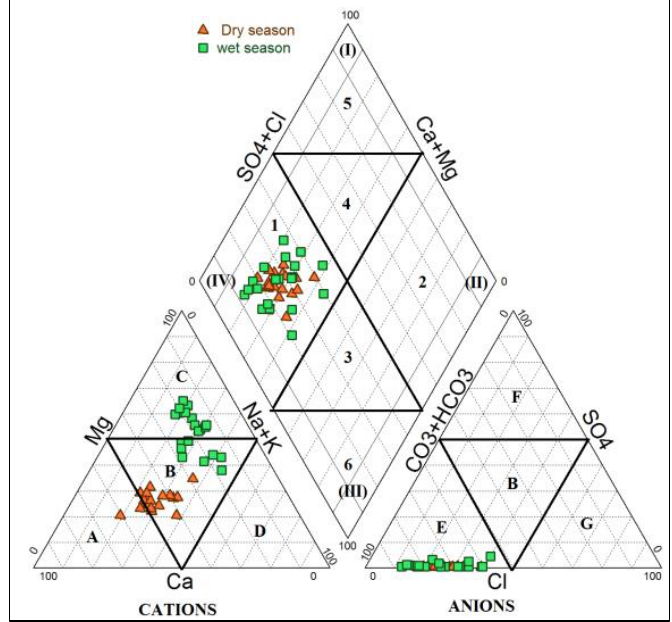
Figure 7. Piper diagram of the spring water samples in the study area (data from [4]).